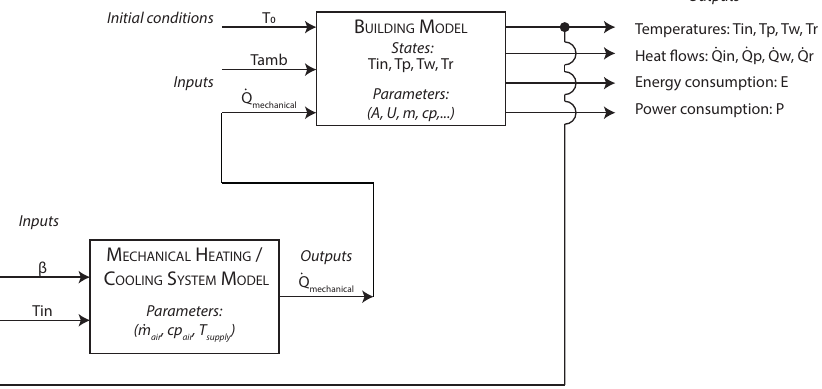
Figure 1. Inputs and outputs of the physical